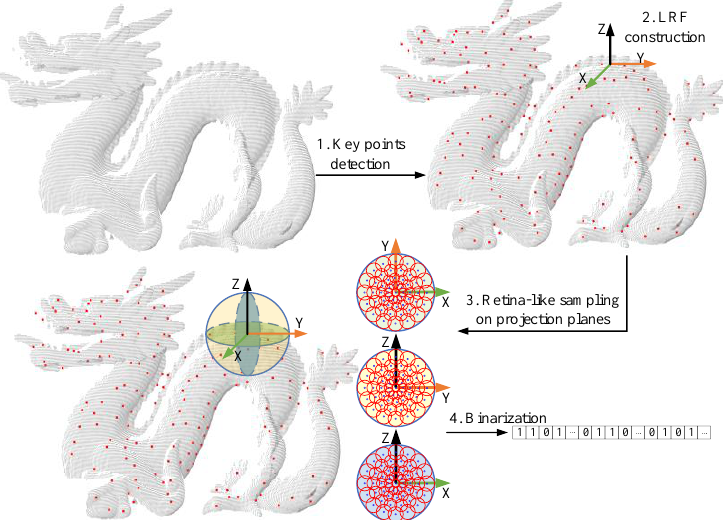
Figure 1. The flow chart of the binary feature description of retina-like sampling in projection planes.